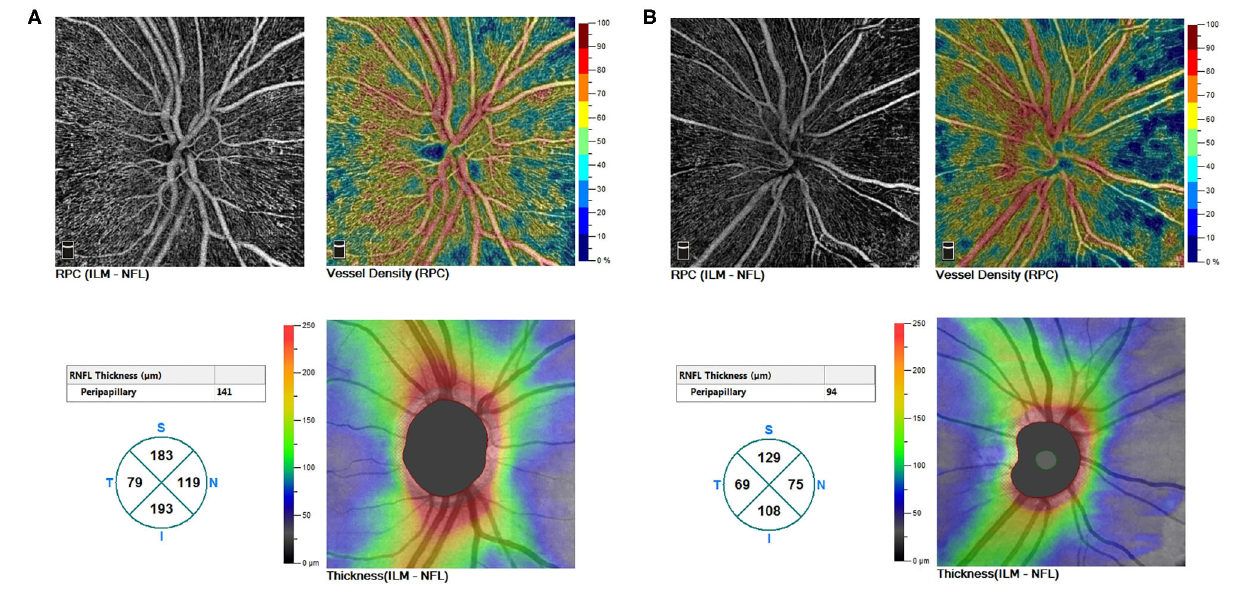
FIGURE 1 | (A) A non-myopic eye without DR (a right eye of a male patient aged 47). (B) A myopic eye without DR (a right eye of a male patient aged 21). Whole VD of ONH, peripapillary VD, and thickness of RNFL demonstrated a decreased trend from non-myopic to myopic eyes. DR, diabetic retinopathy; VD, vessel density; ONH, optic nerve head; RNFL, the retinal nerve fiber